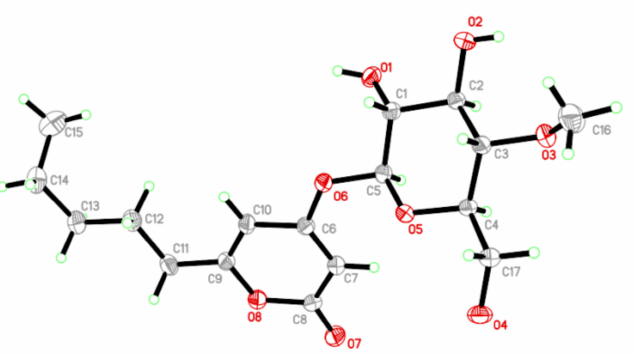
Figure 3. Single-crystal X-ray diffraction of 1 . Note: a different numbering system is used for the structural data (red circle: oxygen atom; blue circle: nitrogen